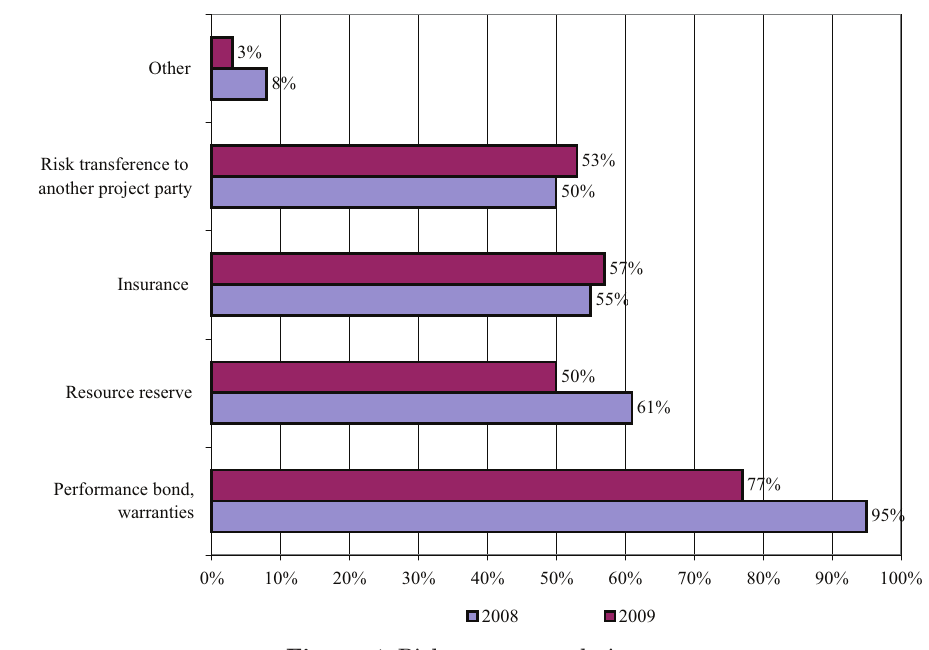
figure 4. risk response techniques employed for construction